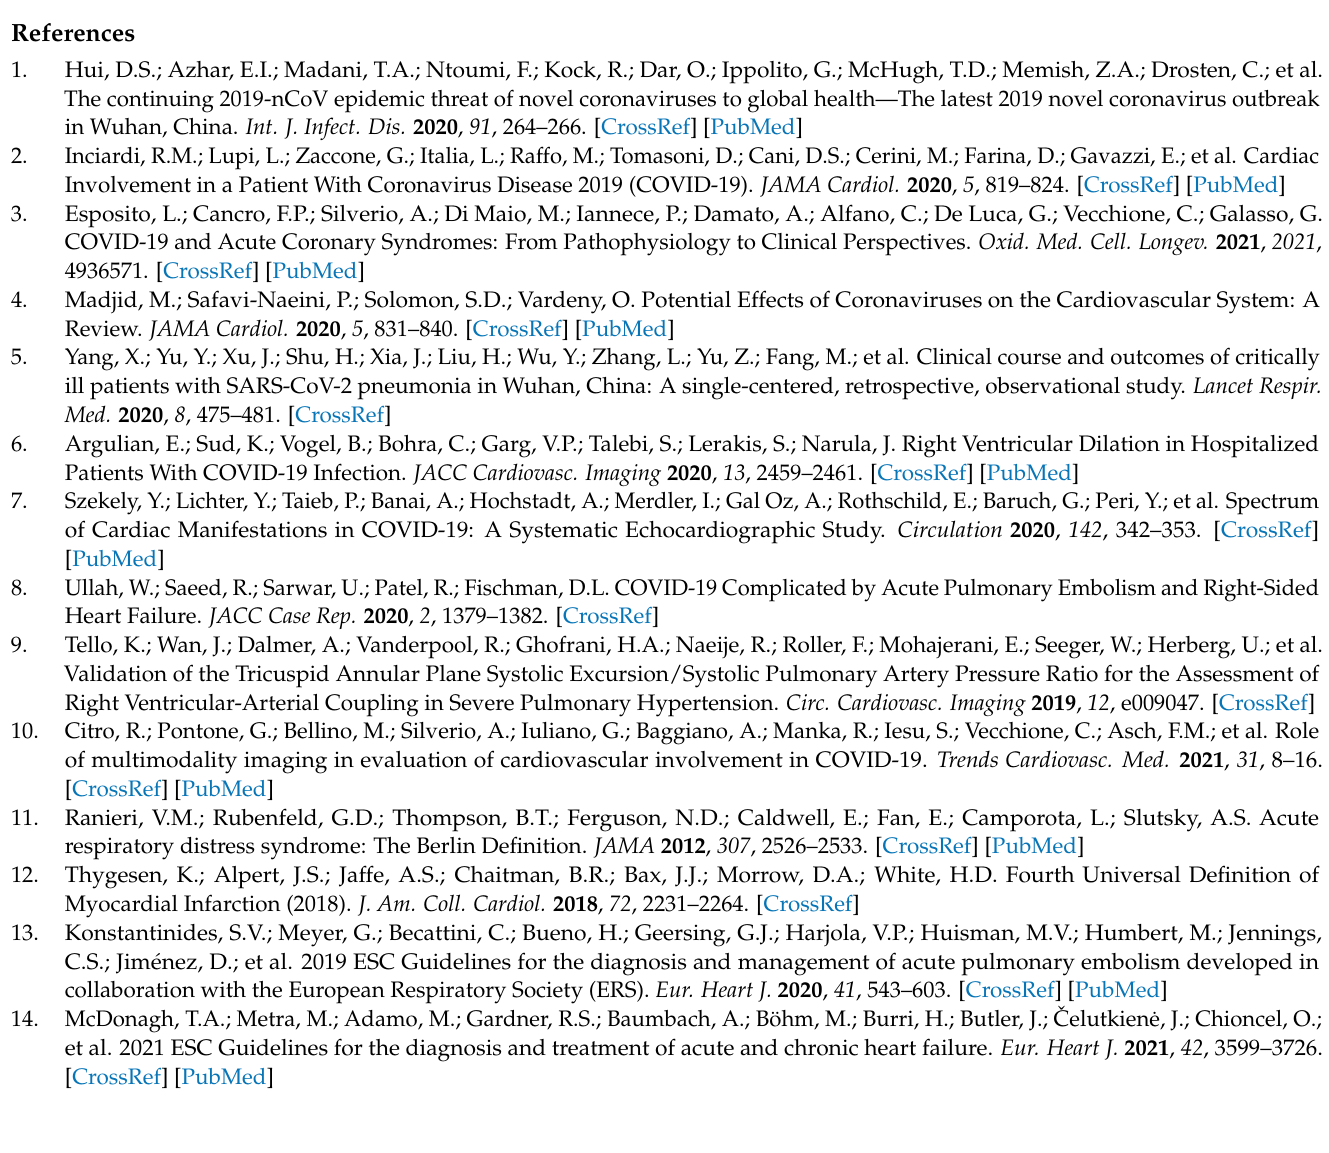
Table S2: Characteristics of the study population stratified by PASP tertiles, Table S3: Characteristics of the study population stratified by TAPSE/PASP